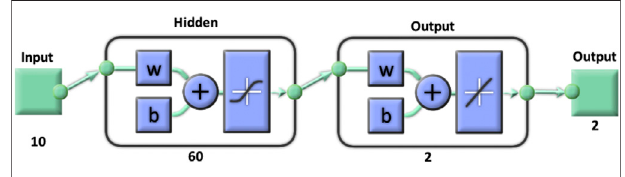
FIGURE 2 | Matlab ANN setup and con fi guration.